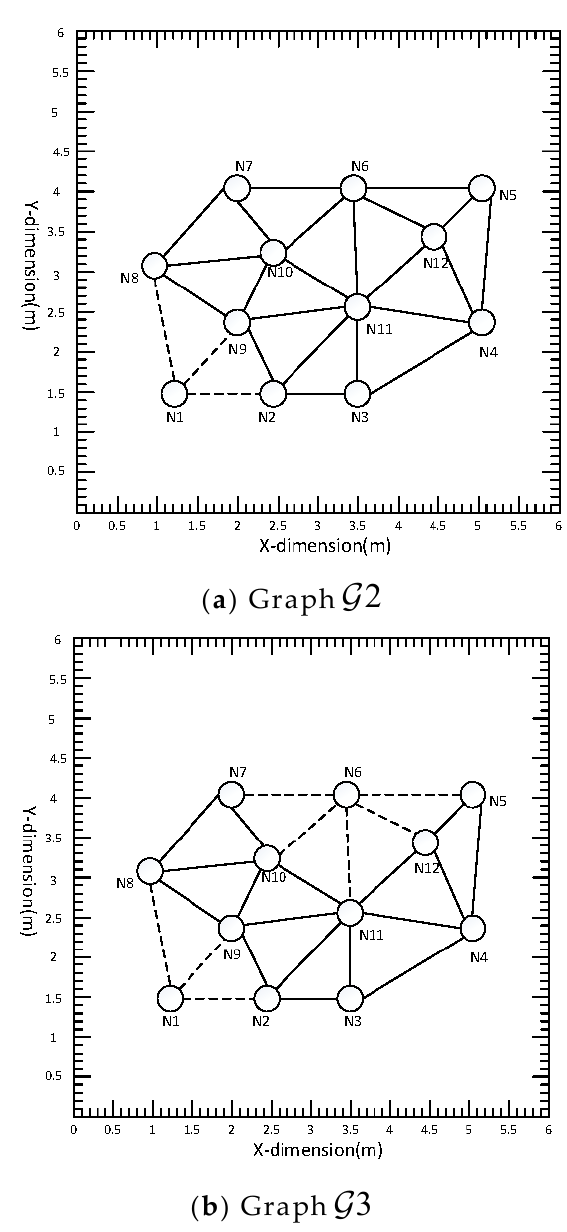
Figure 9. ( a ) Indicates that node 1 is broken, ( b ) indicates that node 1 and node 6 are broken. The